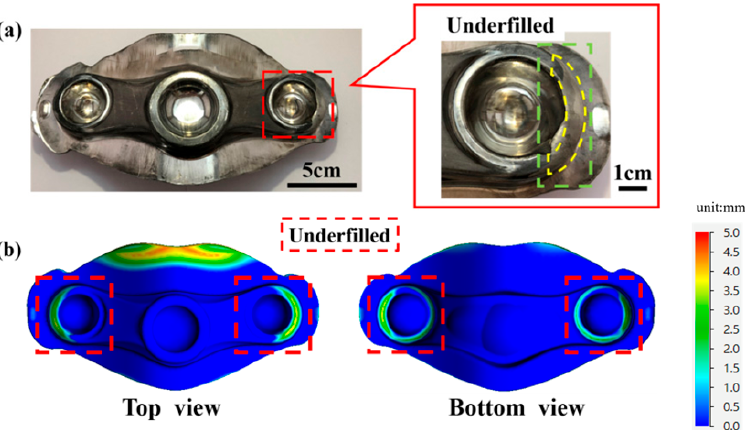
Figure 3. The crown original workpiece. ( a ) Defective forged crown products; ( b ) material-forging simulation diagram of defective crown products.